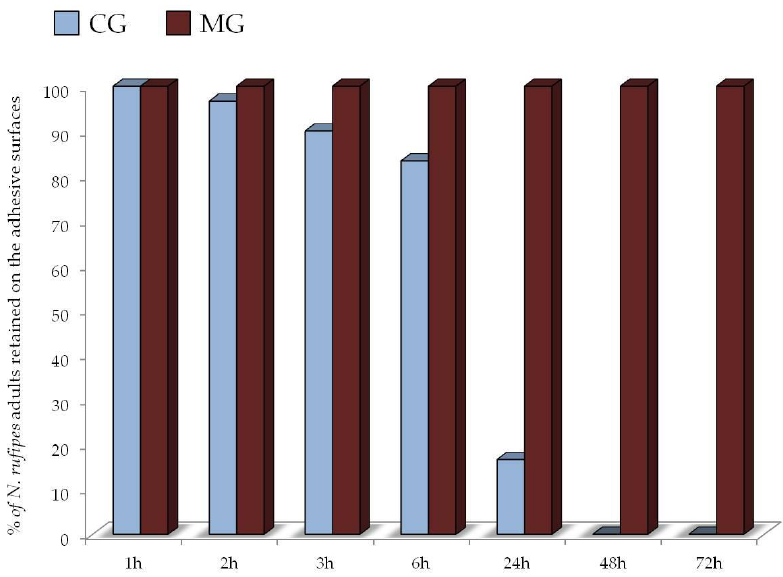
Figure 2. Percentage of Necrobia rufipes adults retained on cockroach glue (CG) and mouse glue (MG) bases after 1 h, 2 h, 3 h, 6 h, 24 h, 48 h, 72 h.